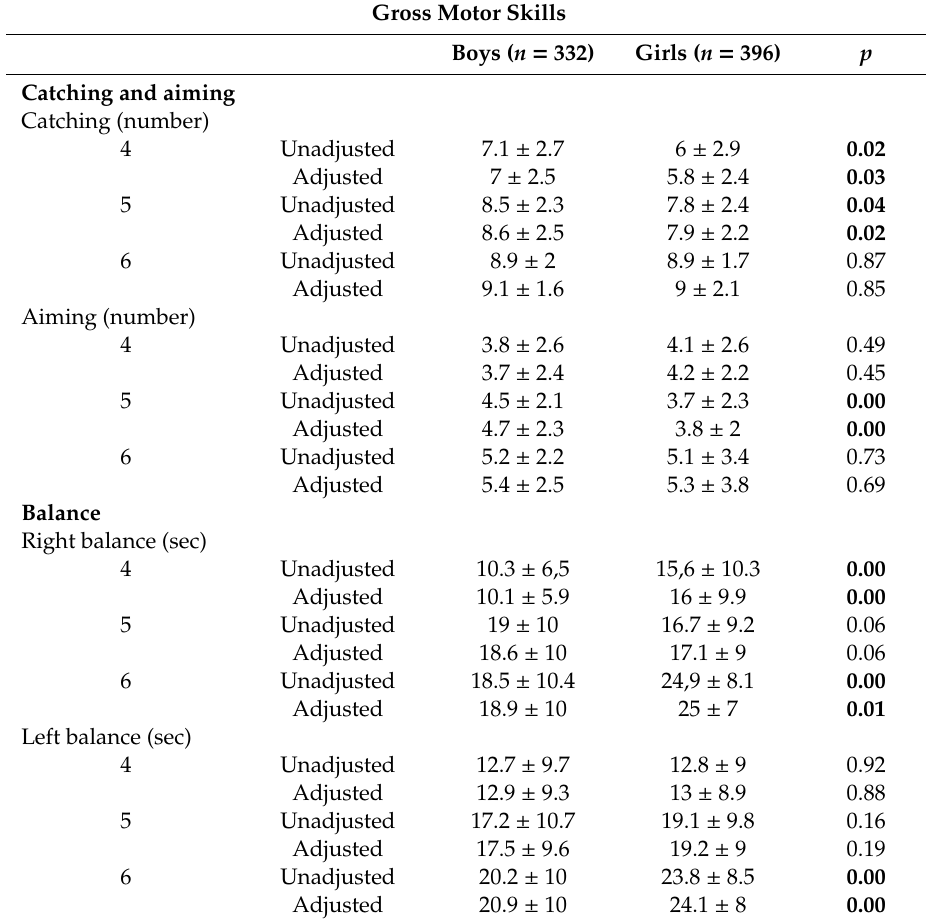
Table 3. Gross motor skills values (Mean ± SD), by age and gender. Gross Motor